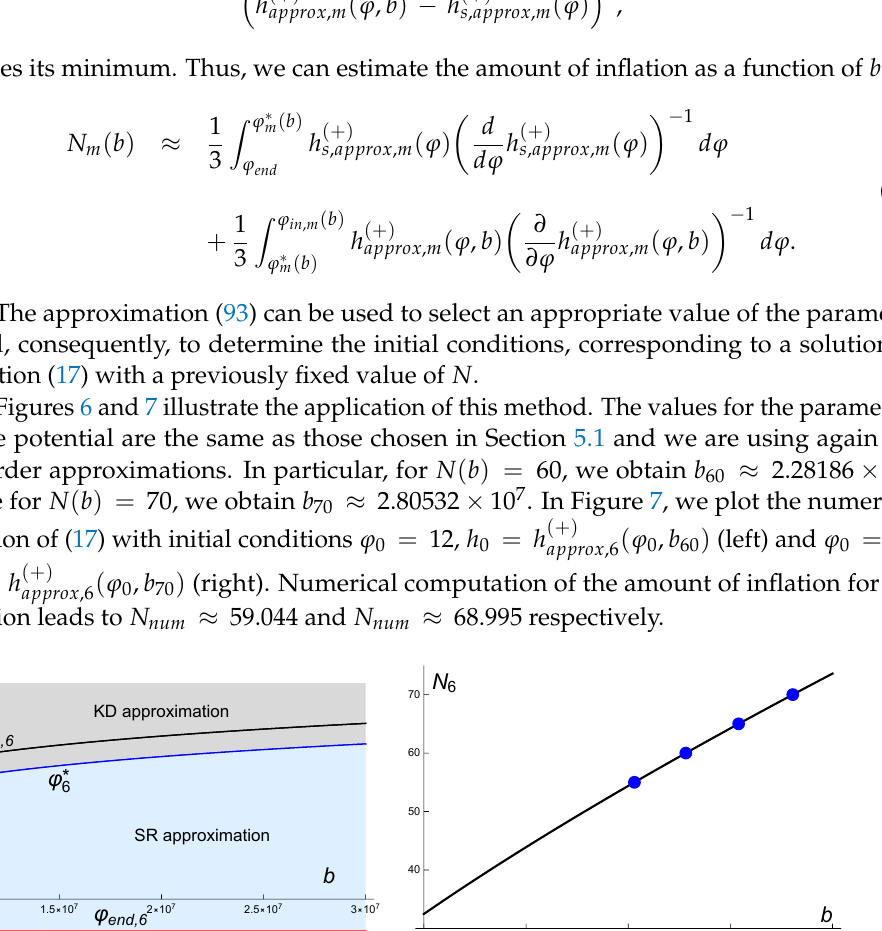
Figure 6. The left figure shows the graphs of the functions ϕ in ,6 ( b ) (black line), ϕ ∗ ϕ end ,6 (red line) for the solutions (25) of (17) with potential (11) and λ = c 2 = 2.5 × 10 − 10 . It also shows the regions in the ( b , ϕ ) plane corresponding to the KD approximation (gray region) and the SR approximation (blue region). The right figure shows the amount of the inflation N 6 ( b ) . The blue dots indicate the values N = 55, 60, 65, and